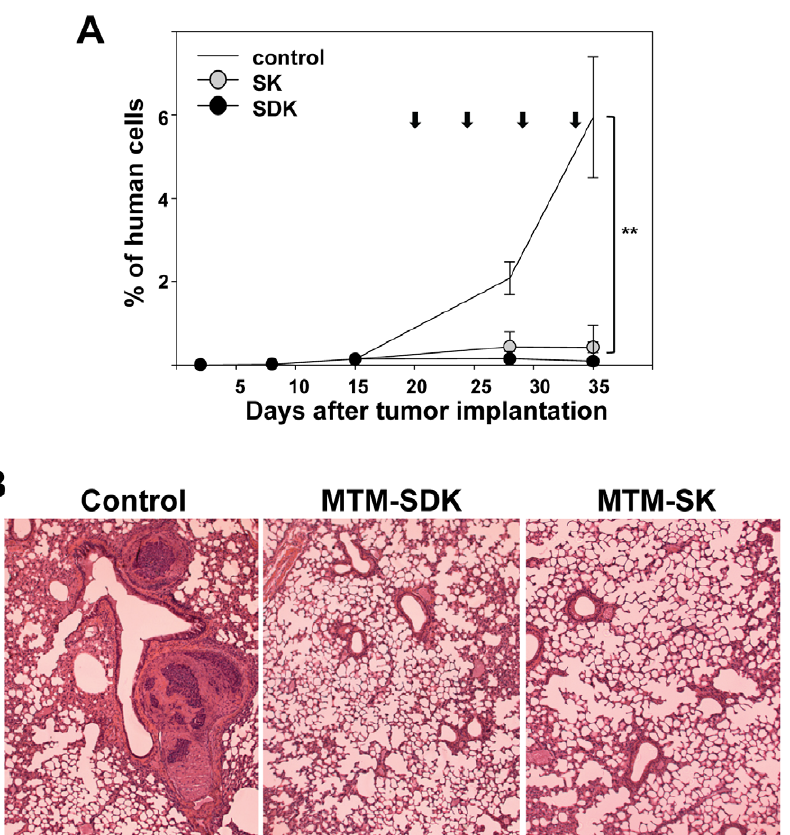
Figure 6. Inhibition of prostate cancer metastasis to the lung by MTM-SDK and MTM- SK. Mice were given PC3 by IV injection into tail vein and then starting 3 weeks later received IP injections of MTM-SDK, MTM-SK or sterile saline solution twice a week for two weeks. The doses of MTM-SK and MTM-SDK were 8 mg/kg and 1.2 mg/kg, respectively. A) qPCR assessment of lung metastasis. Control mice were sacrificed 1 and 2 weeks before treatment and thereafter control and drug treated mice were sacrificed at end of the first and second week of treatment. Results are presented as mean 6 SD of the percentage of human cells relative to total mouse cells in the lung (n=3). Arrows indicate the time of drug injections. B) Microscopic evaluation of lung metastasis. Lung tissue was collected from control and drug-treated mice at the end of the experiment and stained with H&E for histological examination. Representative sections are shown ( 6 20). **, P , 0.001.